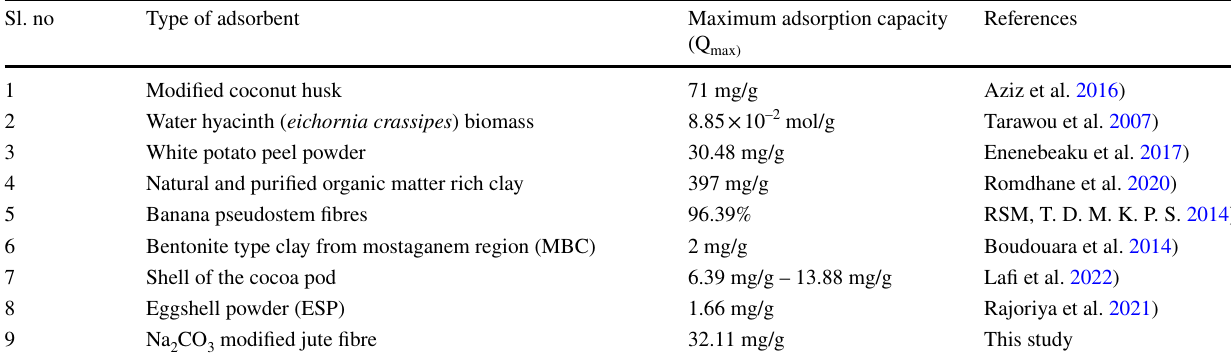
Table 11 MR Dye removal using various non-carbon-based adsorbent Sl. no